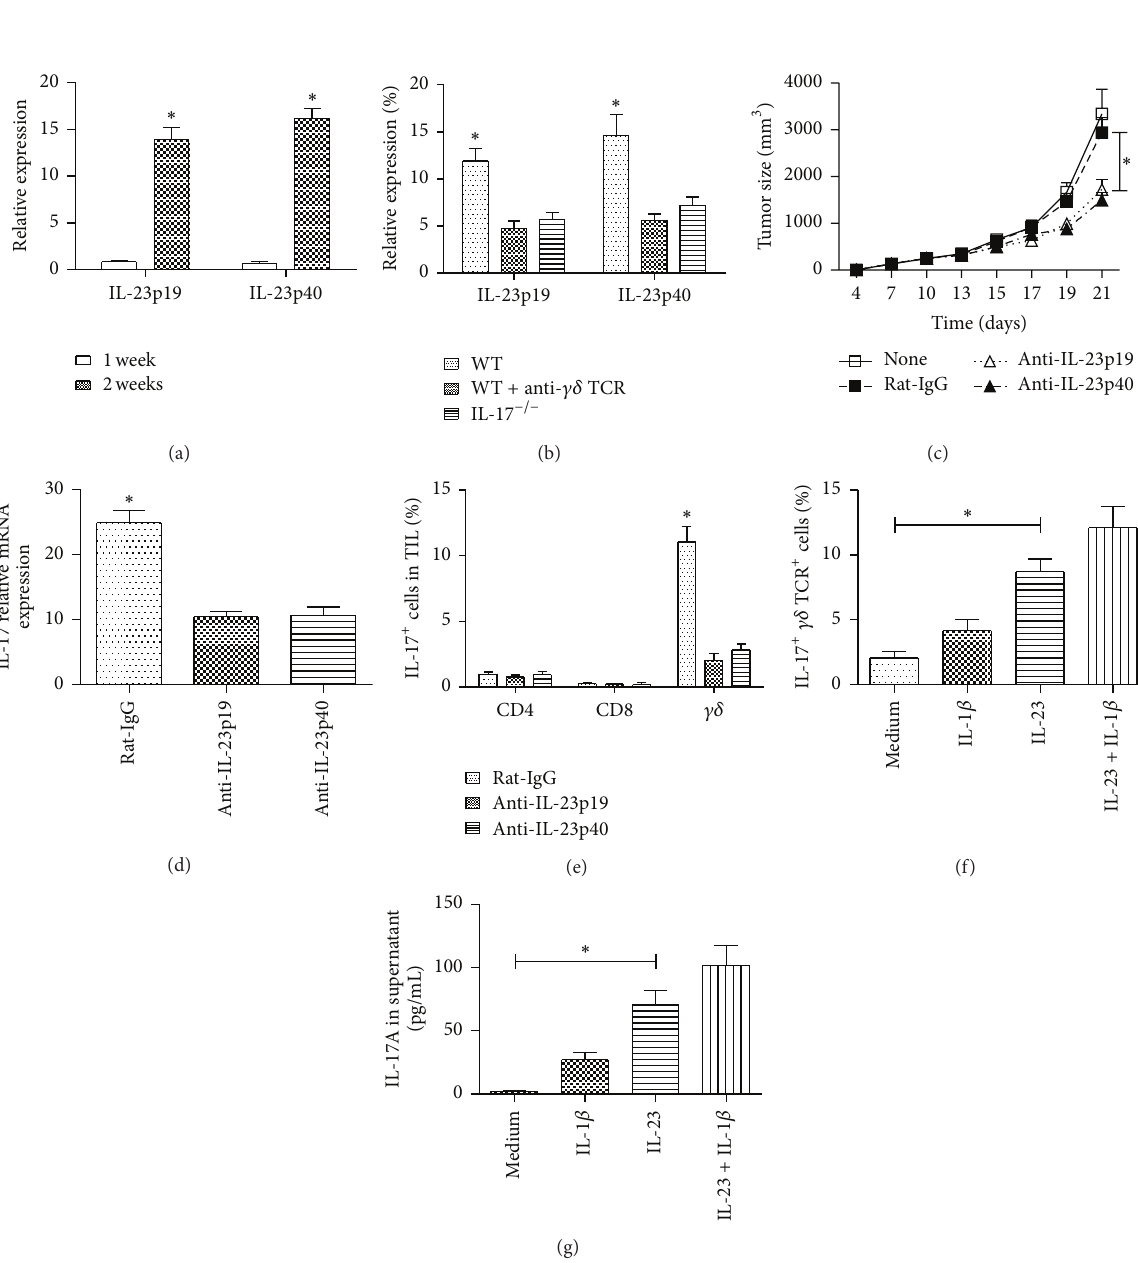
Figure 3: IL-23 is critical for the generation of IL-17 in vivo and in vitro . (a) IL-23p19 and IL-23p40 mRNA levels were analyzed by realtime PCR in tumor tissues from tumor-bearing mice one or two weeks after B16-F10 inoculation ( 𝑛 = 5 ). (b) IL-23p19 and IL-23p40 mRNA levels were analyzed by realtime PCR in tumor tissues two weeks after B16-F10 inoculation from WT, WT + Anti- 𝛾𝛿 TCR, and IL-17 −/− groups ( 𝑛 = 5 ). (c) Wild-type mice were inoculated with B16-F10 tumor cells and injected i.p. with normal rat-IgG, -IL-23p19 mAb, or -IL- 23p40 mAb (100 𝜇 g/mouse) on days 0, 1, 6, 10, and 14 ( 𝑛 = 5 ). Then tumor sizes were monitored ( 𝑛 = 5 ). (d) IL-17 relative mRNA expression in tumor tissues from B16-F10 tumor-bearing mice treated with rat-IgG, -IL-23p19mAb, or -IL-23p40mAb ( 𝑛 = 5 ). (e) The percentage of cells producing IL-17 in control, anti-IL-23p19, and anti-IL-23p40 treated group ( 𝑛 = 5 ). (f) IL-17-producing 𝛾𝛿 T cells after stimulation with IL-23. IL-17 + 𝛾𝛿 T cells were analyzed by flow cytometry after stimulation for 48 hours. Tumor lymphocytes were isolated from tumor-bearing mice 1 week after B16-F10 inoculation. The cells were stimulated with medium, IL-1 𝛽 (50ng/mL), IL-23 (50ng/mL), or the combination for 48 hours. (g) Increase in the secretion of IL-17 from tumor 𝛾𝛿 T cells stimulated with IL-23 in vitro . 𝛾𝛿 T cells were purified from tumor lymphocytes by MACS and were stimulated with medium, IL-1 𝛽 (50ng/mL), IL-23 (50ng/mL) or the combination for 48 hours. After 48 hours of stimulation, the supernatants were collected, and IL-17 concentrations were measured by ELISA kits. The data show means ± SEM of tumor size and are representative of three independent experiments. ∗ 𝑃 < 0.05